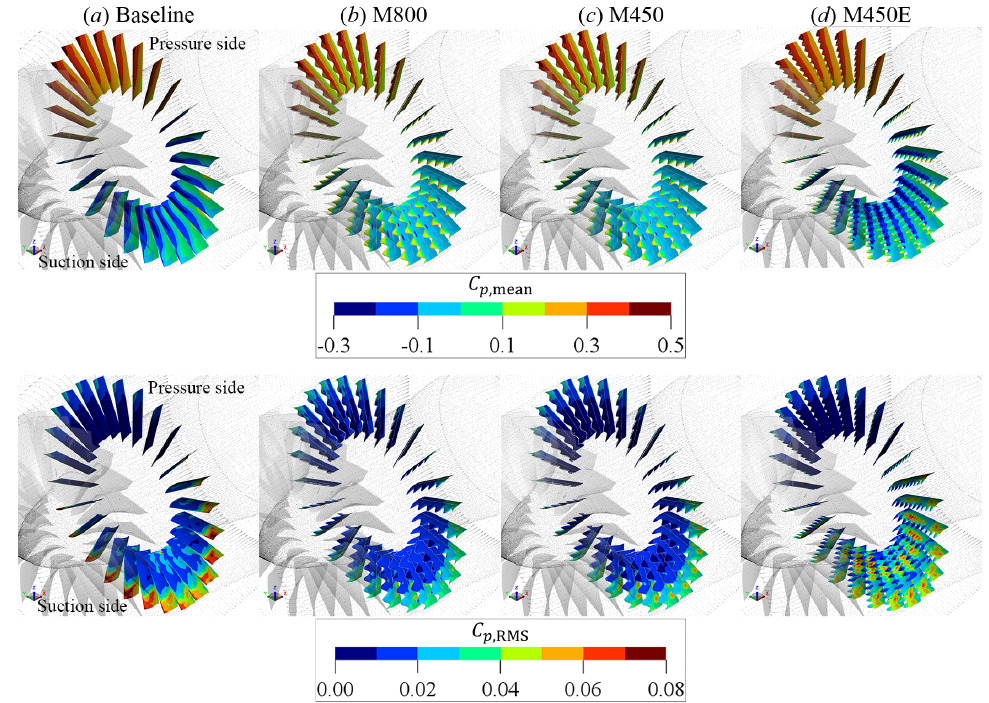
Figure 14. (Isometric view) Contours of time-averaged surface pressure coefficient C p ,mean and the RMS of surface pressure fluctuations C p ,RMS on the OGV